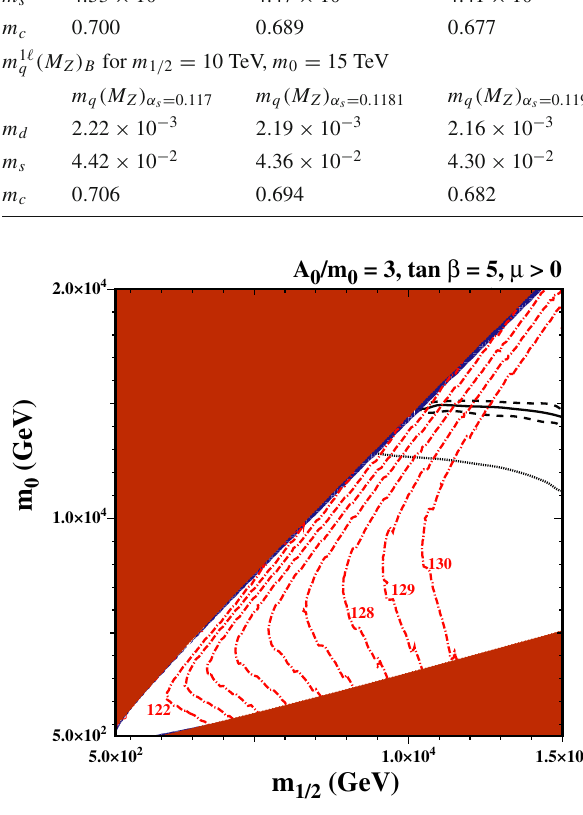
Fig. 7 Sensitivity to the Wolfenstein A parameter for μ > 0 assuming tan β = 5 , A 0 / m 0 = 3 and M in = M GUT . The dashed lines correspond to the variation of A within one standard deviation ( A = 0 . 836 ± 0 . 015)